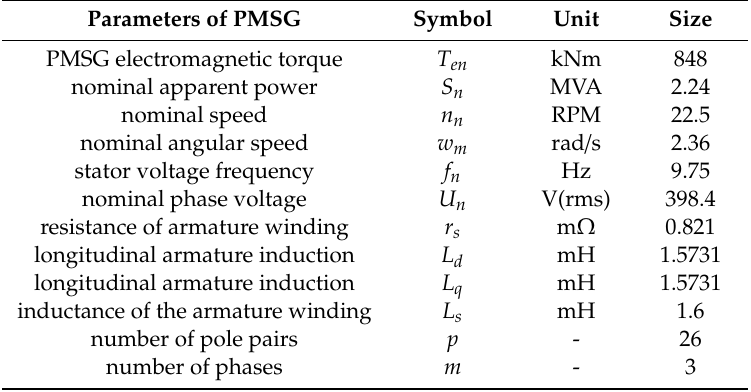
Table 1. Parameters of the PMSG.